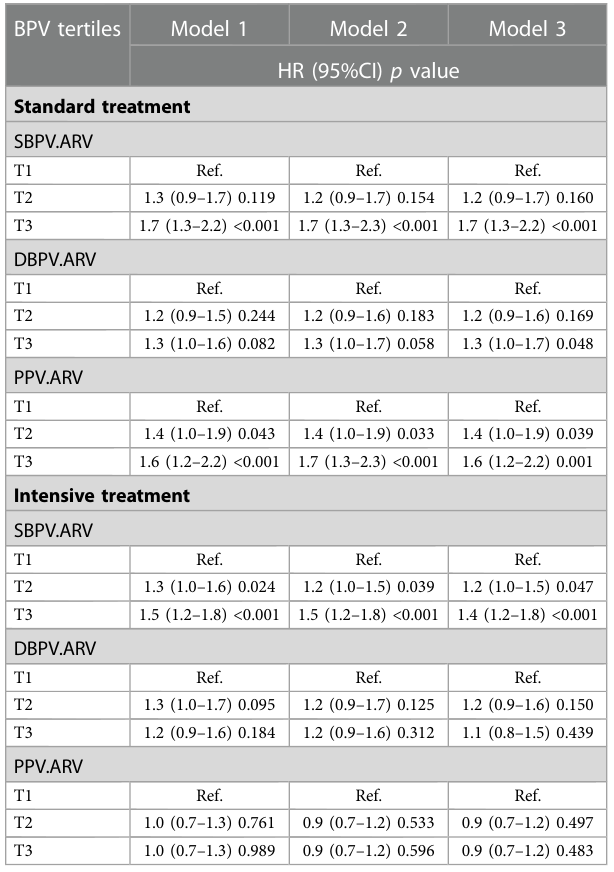
TABLE 2 Association between BPV (SBPV, DBPV and PPV) and MCI in different blood pressure treatment arms.